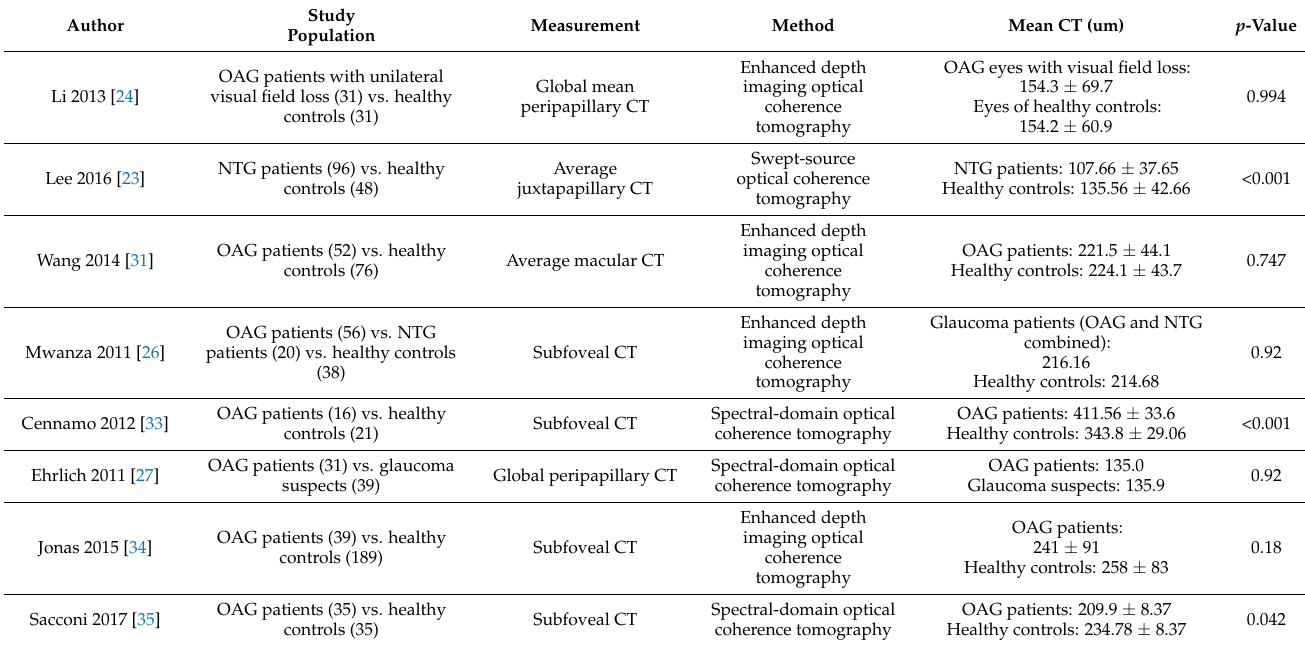
Table 1. Summary of relevant studies investigating choroidal thickness measurement in open-angle patients and healthy subjects. CT: choroidal thickness; NTG: normal-tension glaucoma; OAG: primary open-angle